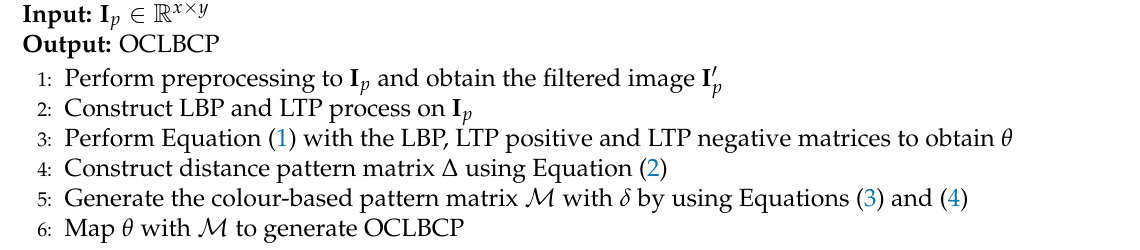
Algorithm 1 Creating colour-based texture description OCLBCP.